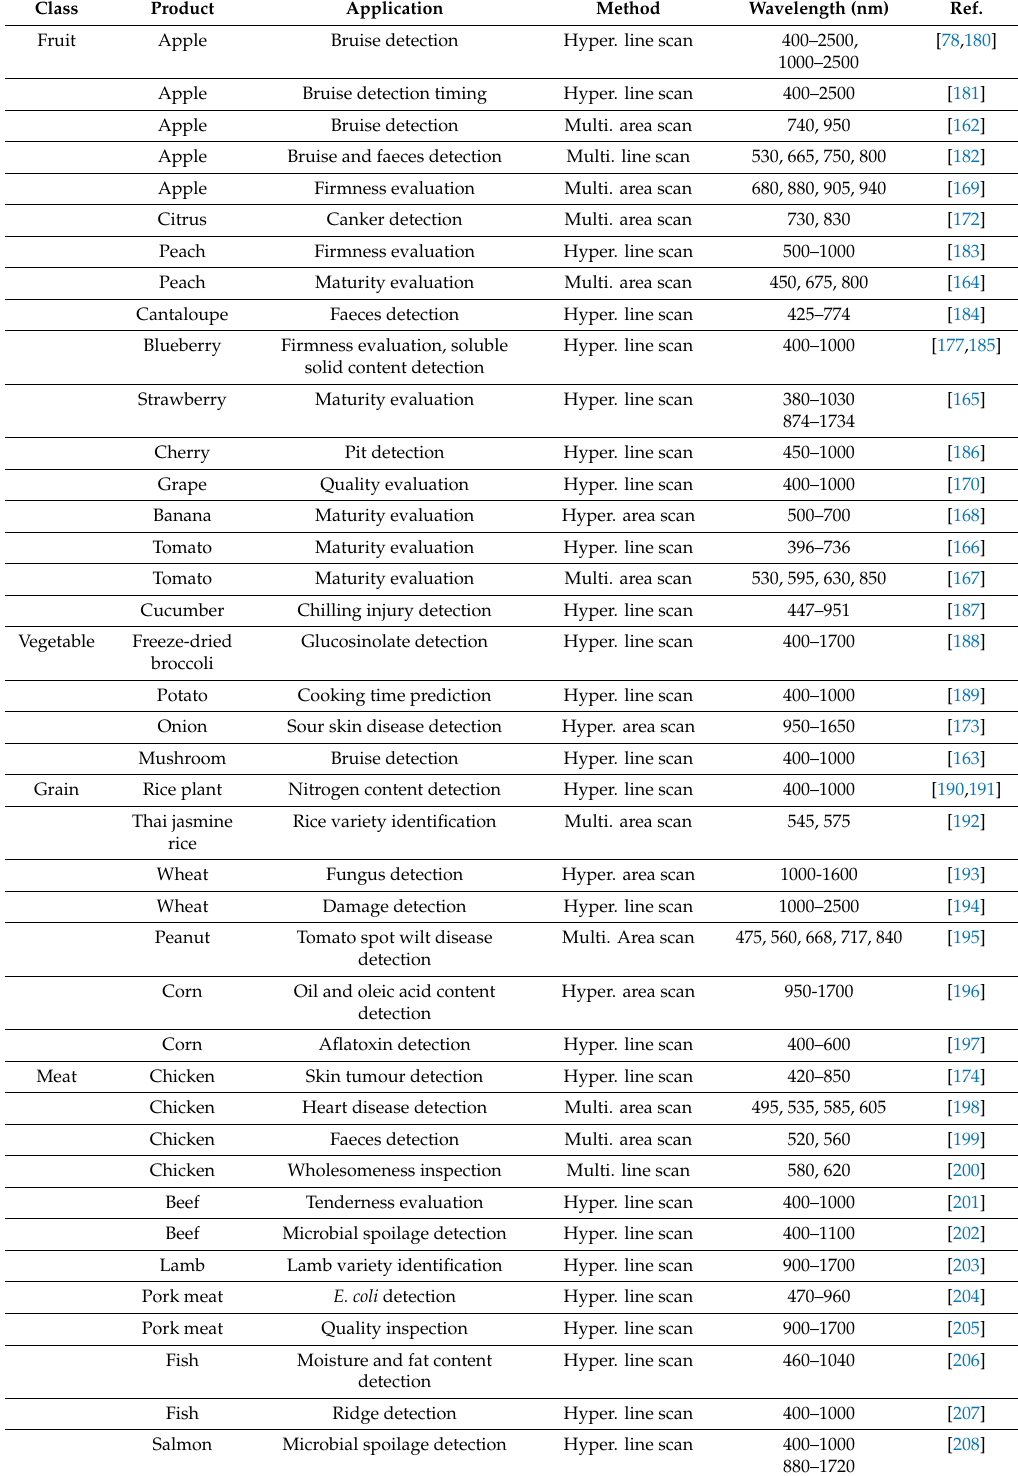
Table 7. Applications of spectral imaging technique in